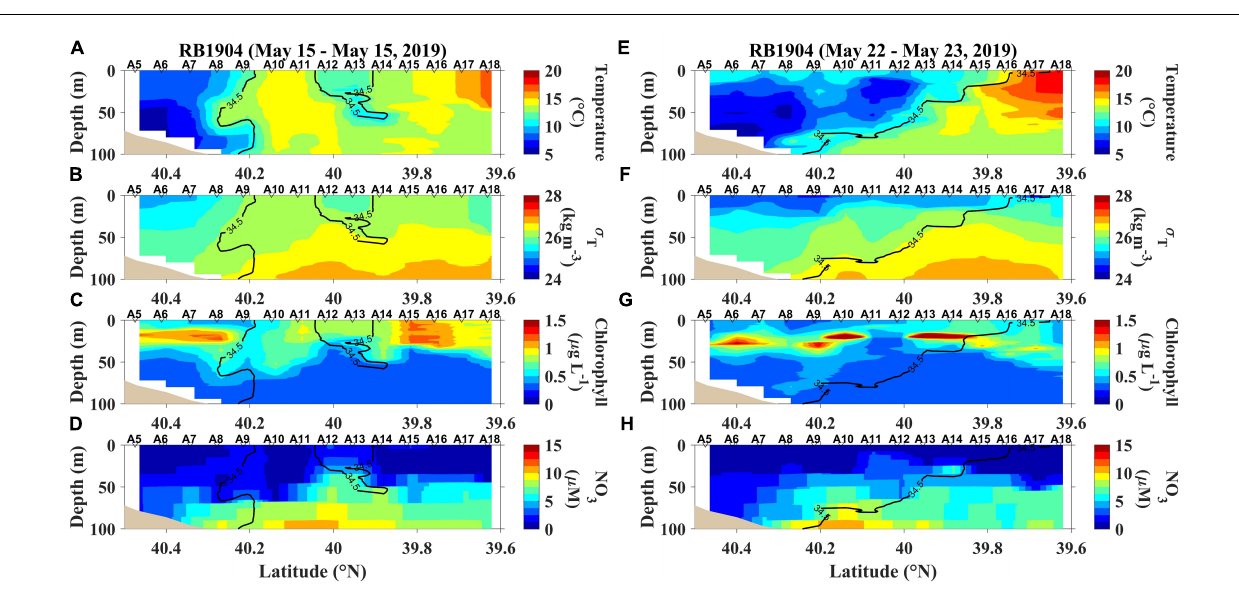
FIGURE 3 | The first and last section occupied during RB1904; (A) temperature, (B) density (expressed as σ T ), (C) chlorophyll and (D) nitrate concentrations (NO 3 ) sampled on May 15, 2019, and (E) temperature, (F) density (expressed as σ T ), (G) chlorophyll and (H) nitrate concentrations (NO 3 ) sampled from May 22–23,